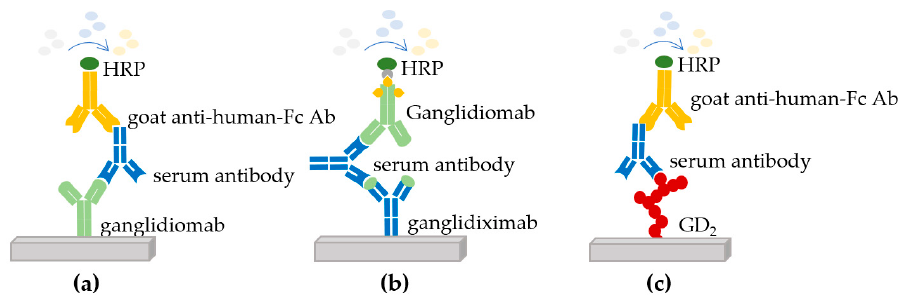
Figure 1. Enzyme-linked immunosorbent assays (ELISA) used to determine the immune response of immunized patients. Three different antigens were used to perform ELISAs to determine the response in the serum of immunized patients: ( a ) against the ganglidiomab vaccine, ( b ) against the human-mouse chimeric antibody ganglidiximab, and ( c ) against GD 2 .